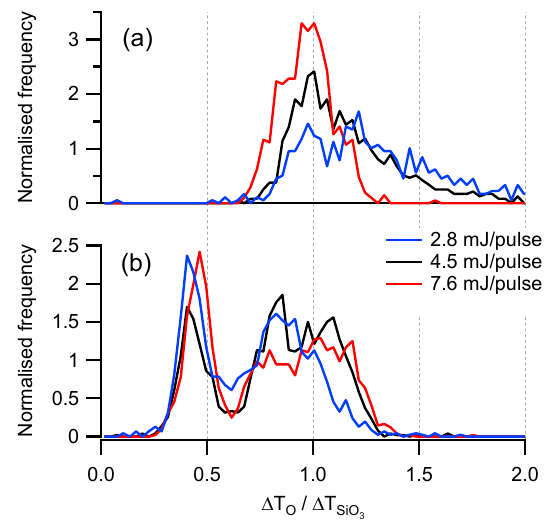
Figure 9. Histograms of the ion arrival times shift ratio ( τ ) of the elemental ion O − and the molecular ion SiO 3 − with different laser pulse energy settings. (a) Kaolinite sample KGa-1b and (b) illite